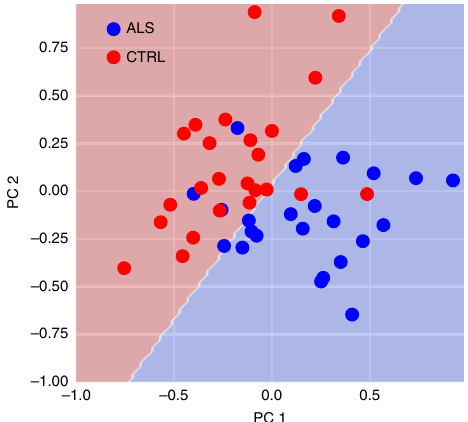
Fig. 5 Classi fi cation of ALS patients based on FA in the corticospinal tracts. The Tract Pro fi les in the two CSTs are submitted to a Principal Components Analysis — the fi rst two PCs form the dimensions of this plot (accounting for about 50% of the variance in the data). The data are separately used to train a support vector machine classi fi er, with a polynomial kernel. The classi fi cation boundary is shown here in the space of fi rst two PCs. This classi fi er performs at 88% accuracy (cross-validated) in discriminating patients from controls. The Jupyter Notebook containing all steps of the analysis is shared here: https://github.com/YeatmanLab/AFQ-